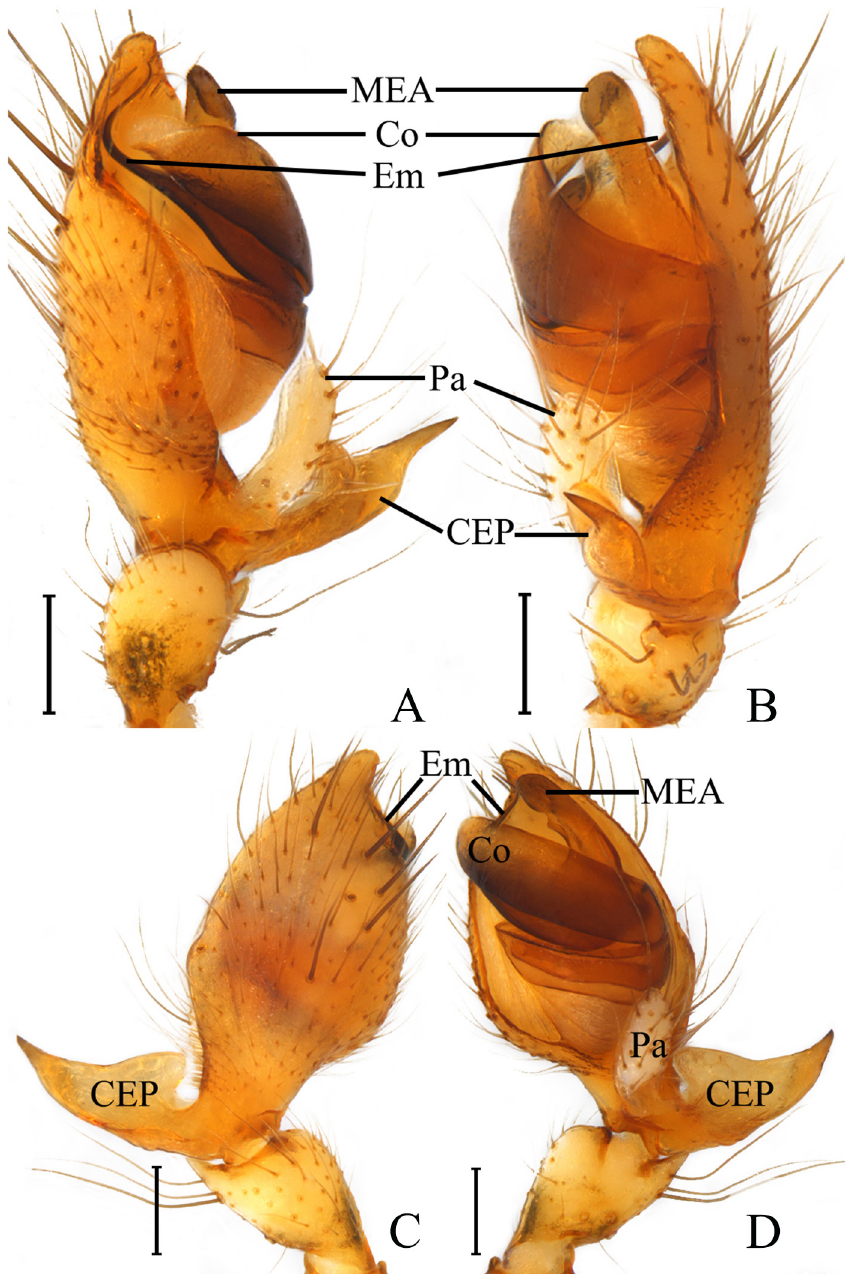
Fig. 7. Meta tangi sp. nov. Left palp of holotype ♂ (HNU-20071010). A . Prolateral view. B . Retrolateral view. C . Dorsal view. D . Ventral view. Scale bars: 0.2